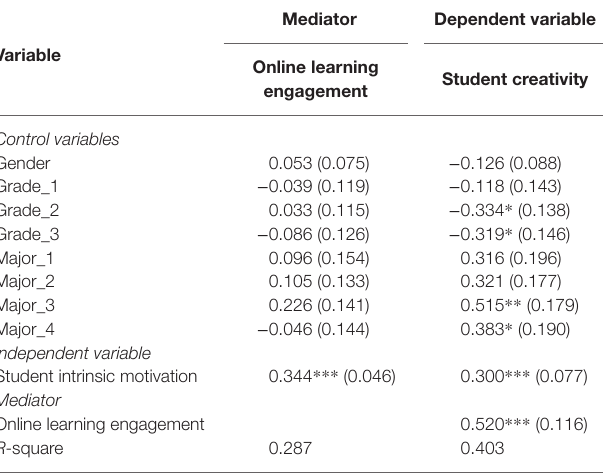
TABLE 3 | Results of the mediation model.